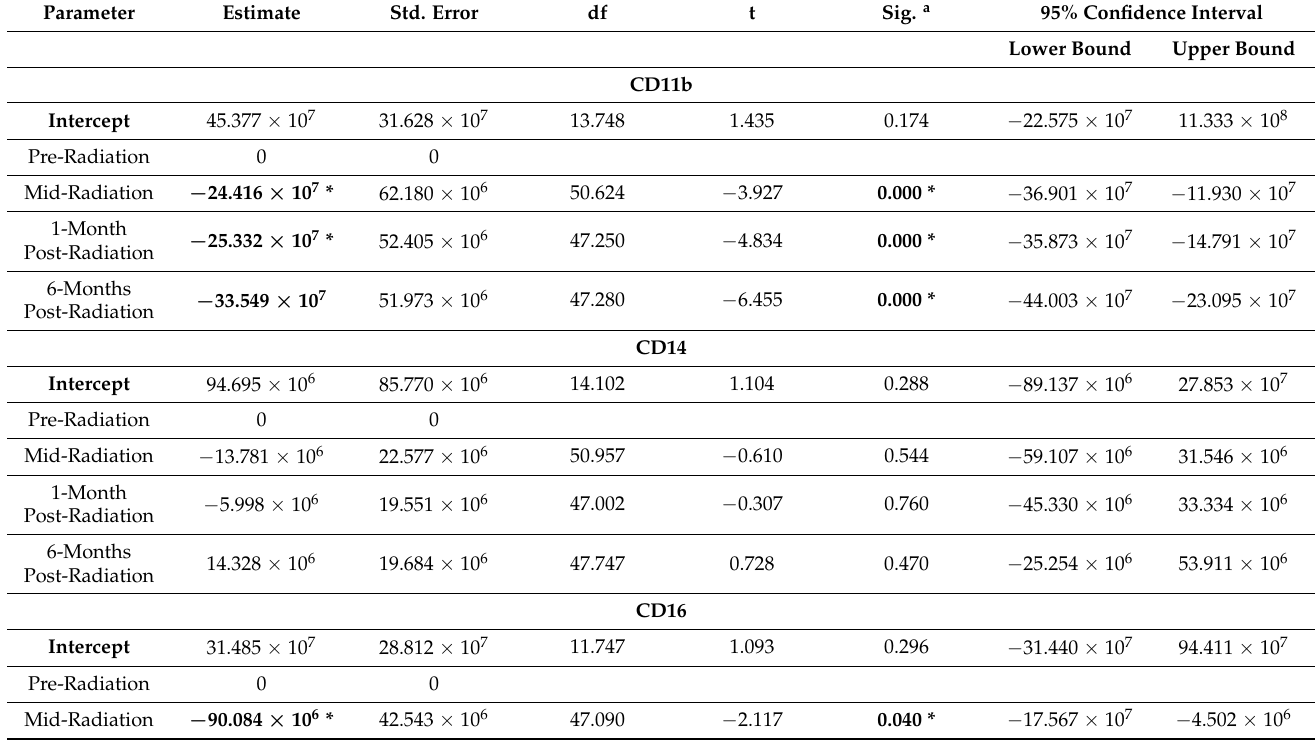
Table A8. The Fixed effect estimates for the oPMN CD markers and H3Cit